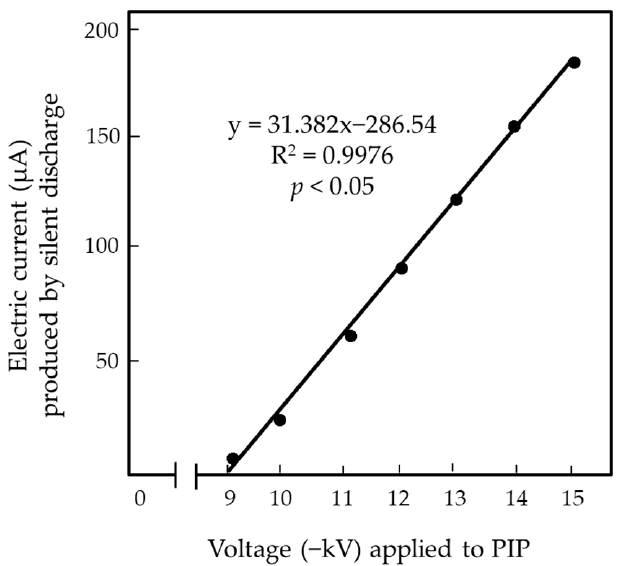
Figure 5. Linear correlation between the voltage applied to the PIP of the EFP and the magnitude of electric current generated by silent discharge from the negatively charged PIP.